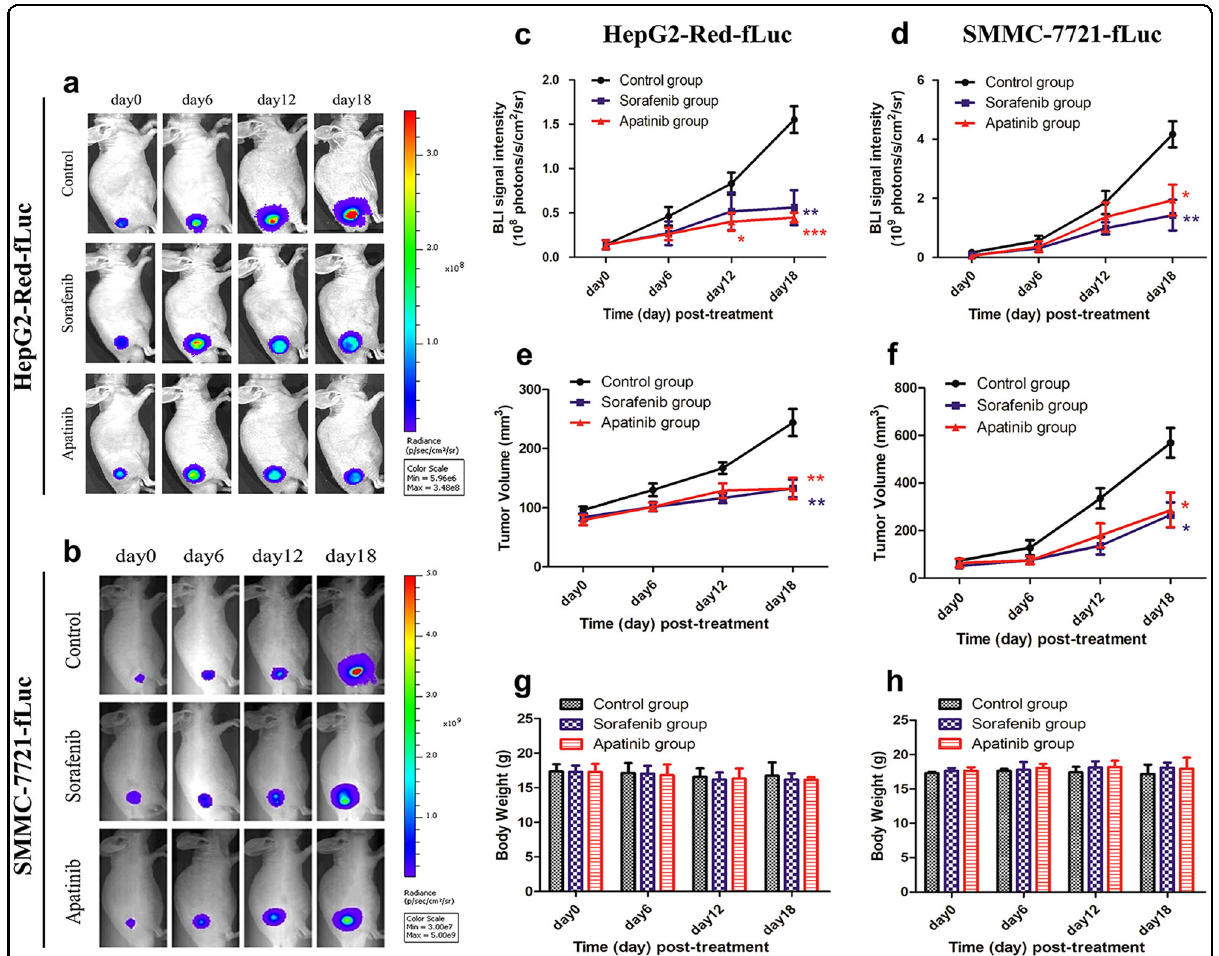
Fig. 2 BLI images of subcutaneous liver tumors ( n = 5 per group). a HepG2-Red-fLuc and ( b ) SMMC-7721-fLuc cell-derived tumor-bearing mice on days 0, 6, 12, and 18 post-drug treatment. Changes in BLI signal intensity, tumor volume, and mouse body weight in mice bearing HepG2-Red- fLuc ( c, e, g ) and SMMC-7721-fLuc ( d, f, h ) cell xenograft tumors were evaluated. (*) P < 0.05, (**) P < 0.01, (***) P < 0.001 vs. the control